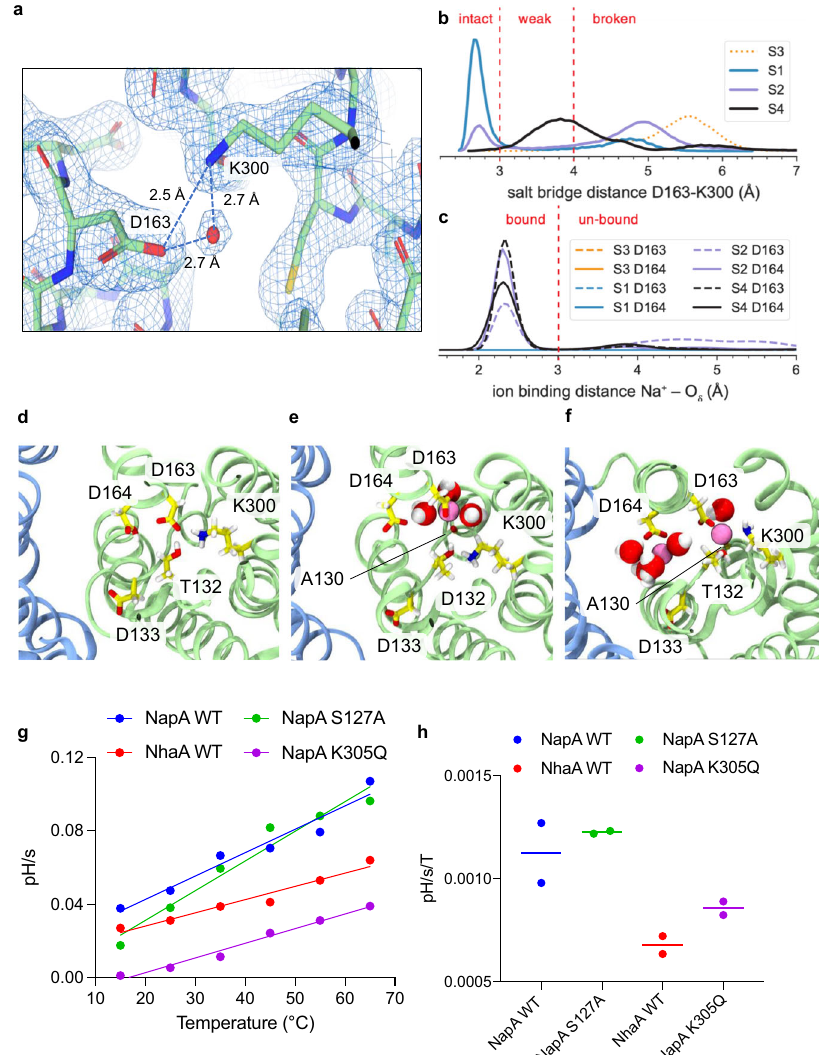
Fig. 4 | MD simulation of ion binding and In fl uence of salt-bridge on temperature-dependent rates. a The monoLCP-NhaA structure with its electron density 2Fo-Fcmapat2.5 σ , showing the well resolved salt-bridge betweenAsp163- Lys300 and a water molecule close-by . b Distribution of the salt bridge distance between D163 and K300 in MD simulations at high pH, measured as the minimal distance between a carboxylate oxygen of D163 and the amide nitrogen of K300. The protonation states in the binding site were varied (S3: 3H + bound, S1: 2H + bound, S2: 1H + bound, S4: no H + bound, see Methods for details). The D163-K300 saltbridgeisconsideredintactfordistances<3Å,weakfordistancesbetween3and 4Å,and broken for>4Å. c Distribution of the minimalNa + ion-carboxylate oxygen distance for the residues D163 (dashed) and D164 (solid). A Na + ion is considered bound for distances <3.5 Å. MD data for ( a ) and ( b ) were collected for each pro- tonation state (S1 – S4) and aggregated over three repeats and protomers A and B and plotted as a Gaussian kernel density estimates (KDE) with bandwidth 0.05 Å. d Intact salt bridge without any ion binding in state S1, the doubly-proton bound